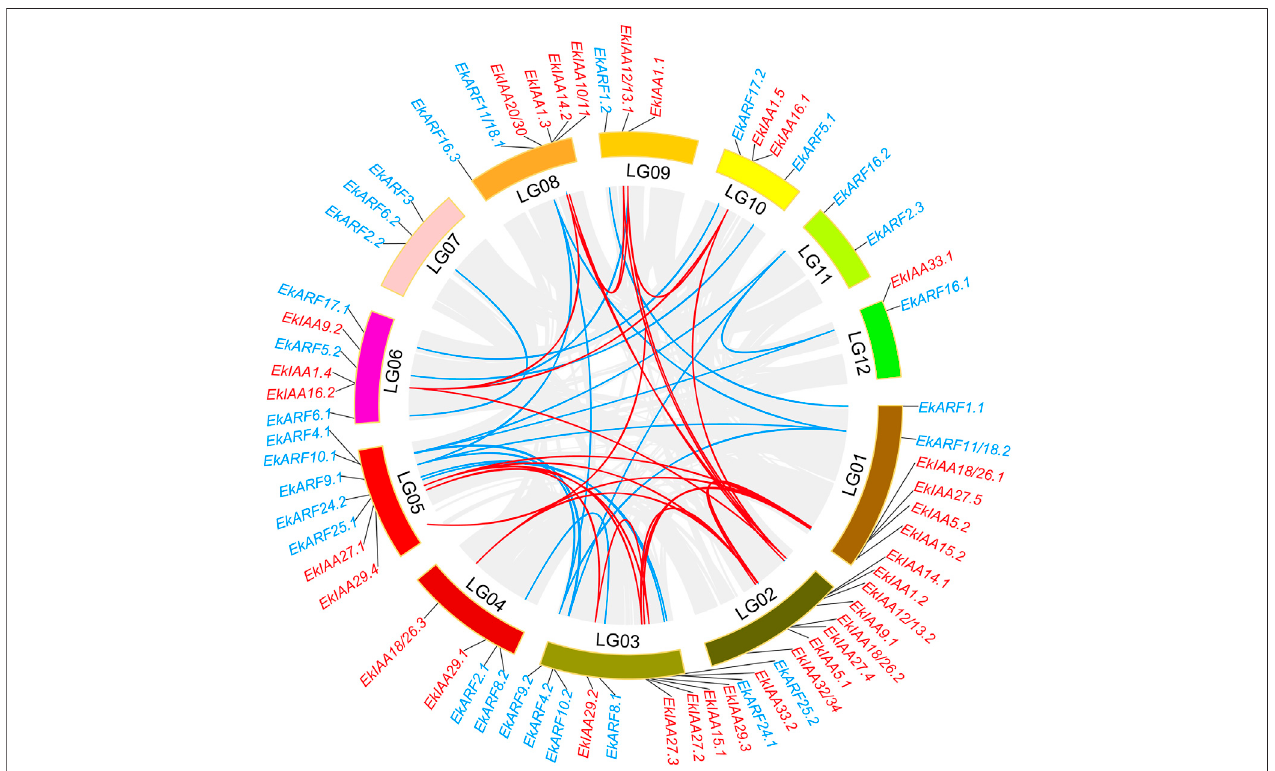
FIGURE 3 | Chromosomal locations and segmental duplicated genes for 34 EkIAA and 29 EkARF genes. Linkage group numbers (LG01 – LG12) are shown at the bottom. Gray lines show all synteny blocks in the E. konishii genome, red lines show segmental duplication of IAA genes, and blue lines show segmental duplication of ARF